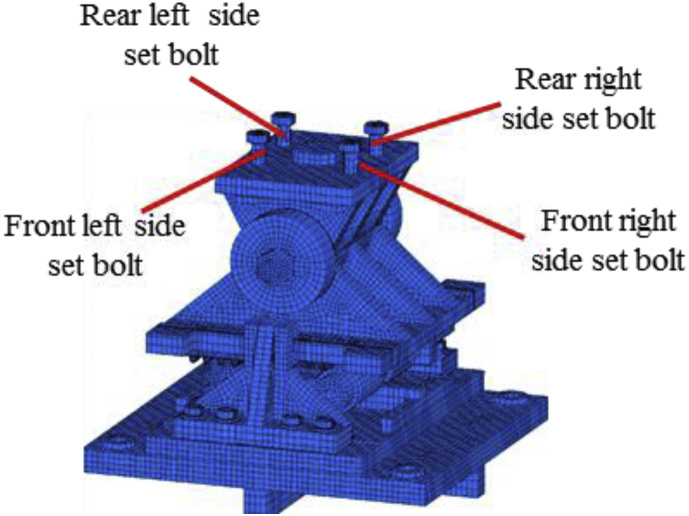
Layout of set bolts.